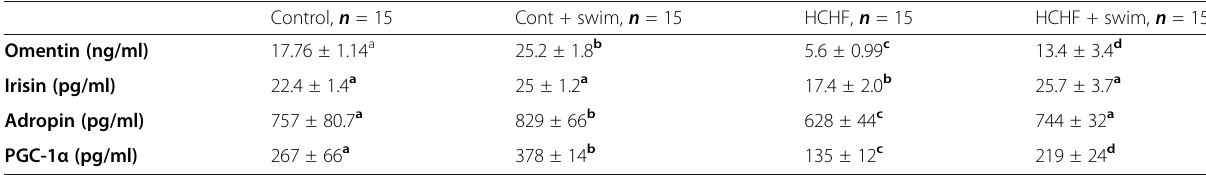
Values are expressed as mean ± standard error (SE). n denotes number of rats in each group. Different letters (superscripts a, b, c, d) indicate statistical differences (one-way ANOVA with post hoc Tukey test. A value of p < 0.05 was considered statistically